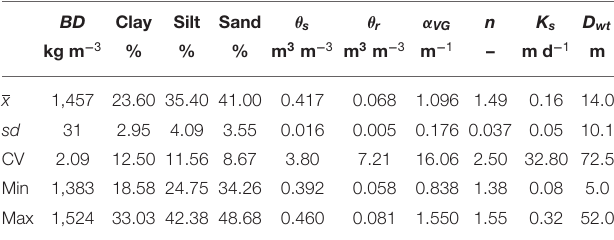
TABLE 1 | Climate annual mean variables ( ET 0 , P , AI , ET p , E p , T p ), soil physical ( D rz , D wt , BD , clay, silt, sand), and hydraulic ( θ s , θ r , α VG , n , K s ) parameters and vegetation characteristics ( LAI ) at Sukhbaatar, Arvaikher, and Saikhanovoo experimental sites. TABLE 2 | Statistics of soil physical and hydraulic properties for six functional